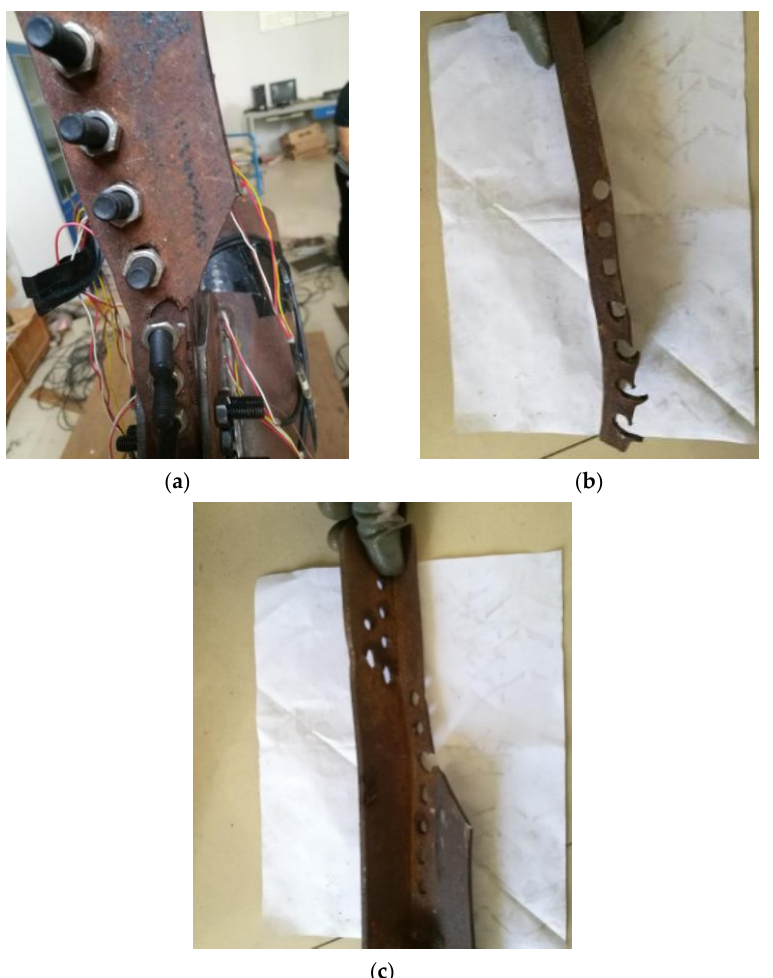
Figure 8. ( a ) Failure of DLDPJ after unloading; ( b ) connecting short angle steel after unloading of DLDPJ; ( c ) connecting long angle steel after unloading of DLDPJ.